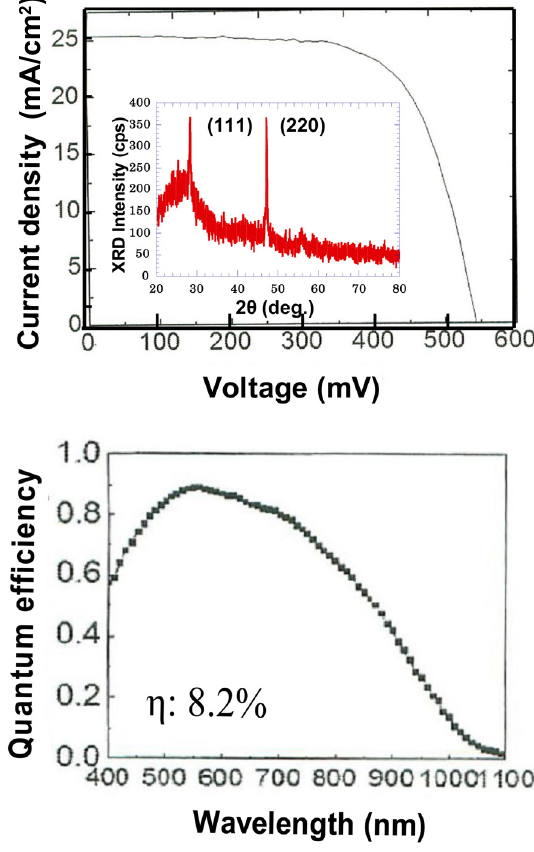
Fig. 6. I - V characteristics and QE spectra of n-i-p µ c-Si thin- film solar cells with textured AZO. The intrinsic µ c-Si:H:Cl layer used was 2 µ m thickness and fabricated from a SiH 2 Cl 2 and H 2 mixture by rf PE-CVD. Inset shows the XRD pattern of corresponding µ c-Si